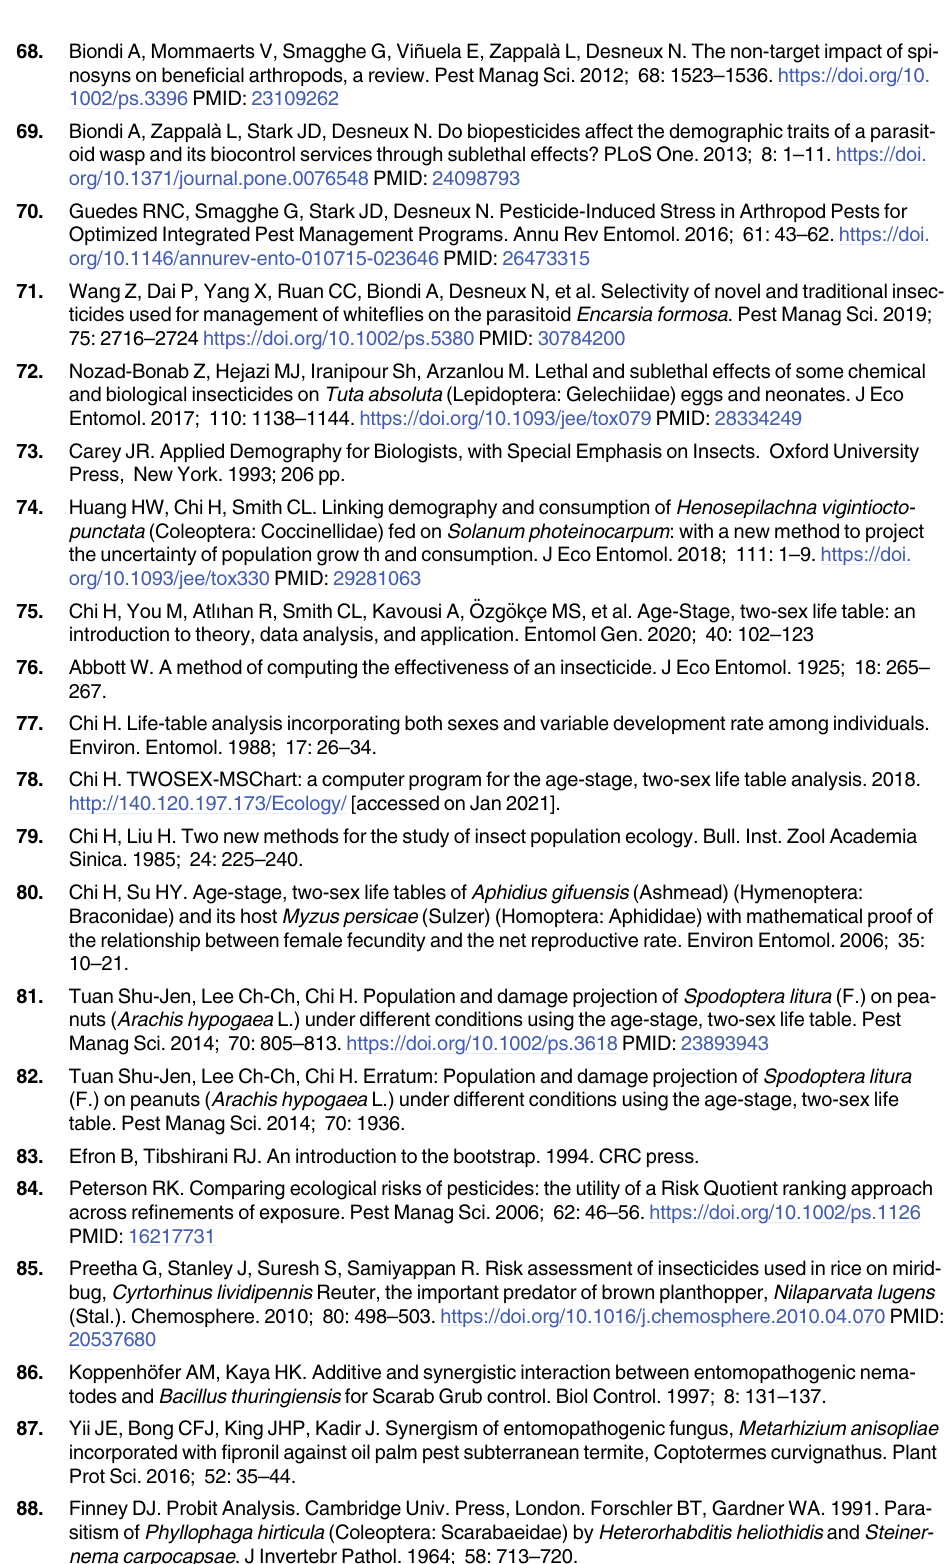
table. Pest ManagSci. 2014; 70: